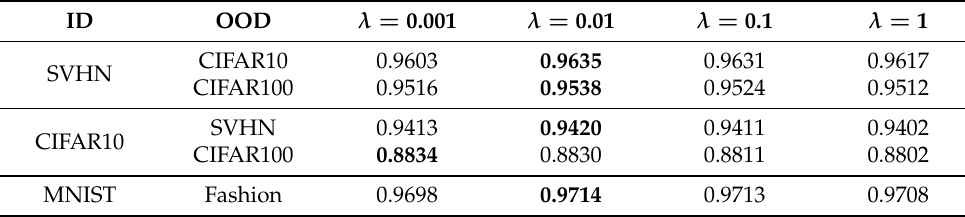
Table 9. Comparison of the OOD detection performance measure by AUROC with different settings of λ . Bold numbers are superior